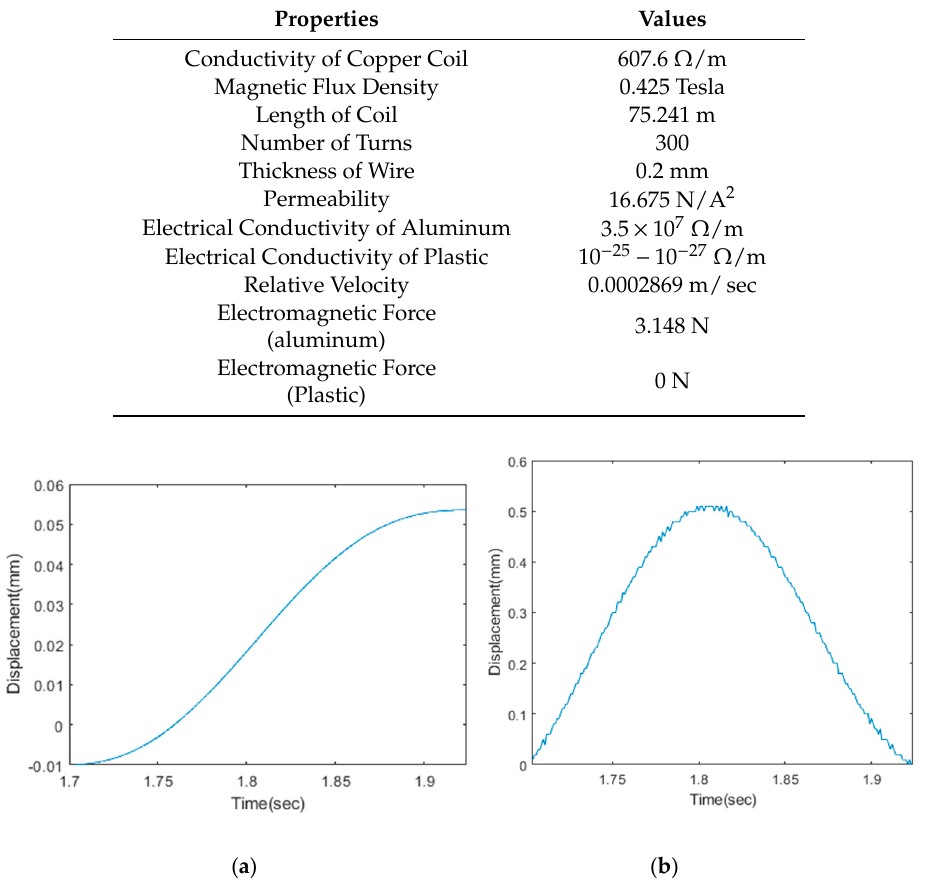
Table 6. Electromagnetic damping force for two di ff erent materials.